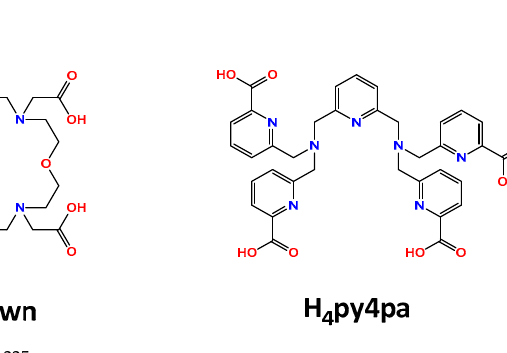
Figure 2. Chemical structures of main 225 Ac chelators.